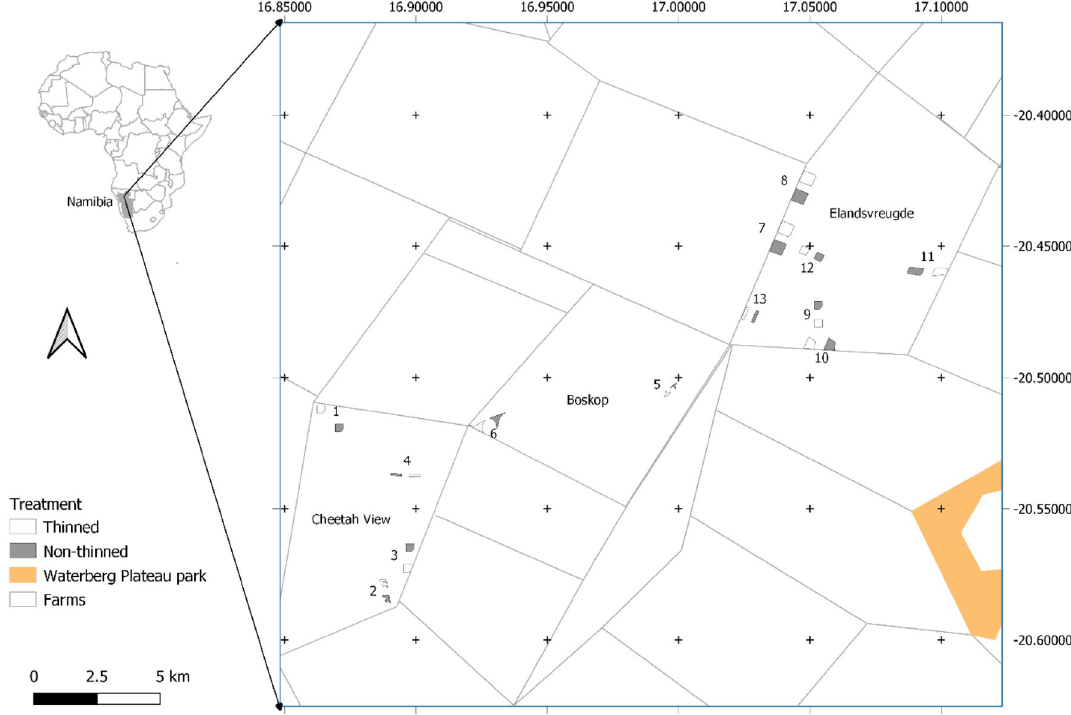
Figure 1. Location of the study area within the north-central farmland of Namibia. Grey squares indicate non-thinned and open squares indicate thinned plots. Block pairs are numbered 1–13. Map created with